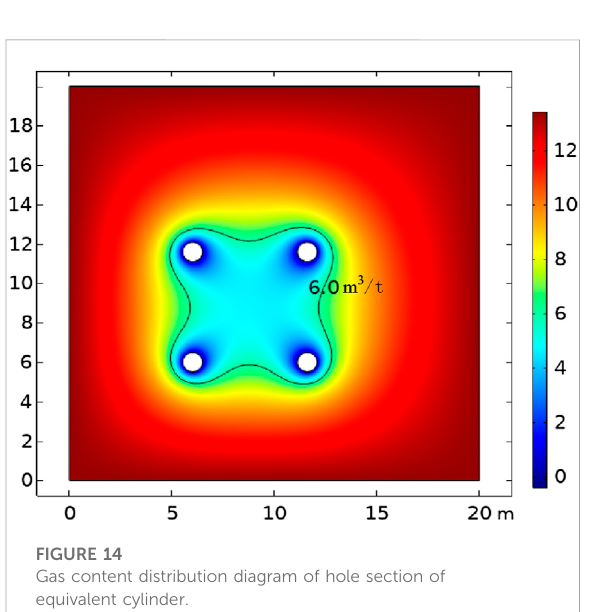
FIGURE 14 Gas content distribution diagram of hole section of equivalent